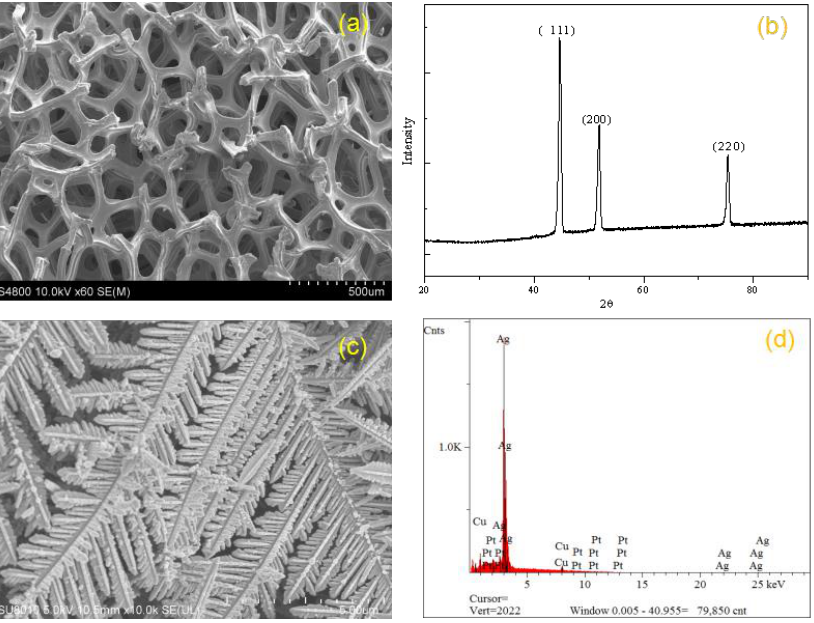
Figure 2. Characterization of Cu foam and Ag – Cu: SEM of Cu foam ( a ) and Ag – Cu ( c ); XRD of Cu foam ( b ); EDX of Ag – Cu ( d ).